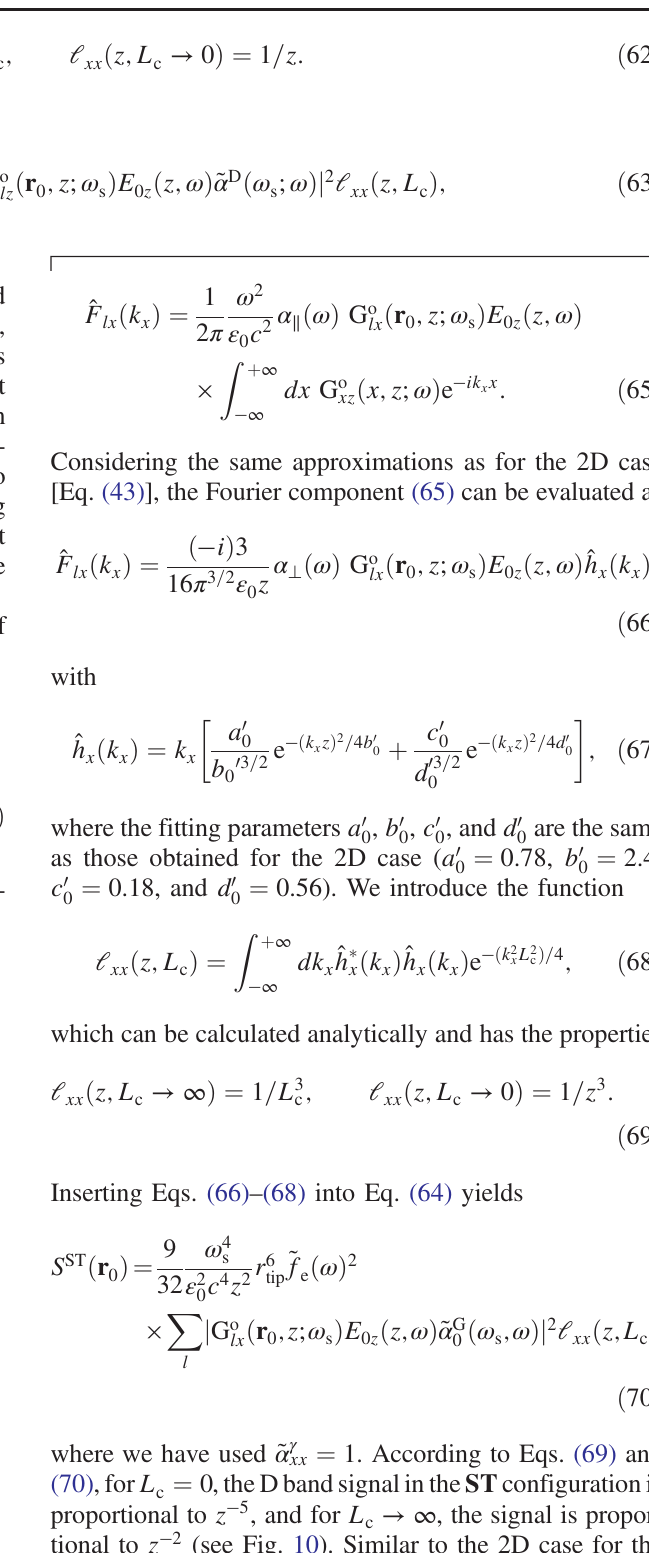
FIG. 9. Dependence of the TST of the D band on tip-sample separation z . Panels (a-d) account for different values of L 30, and 45 nm, respectively, as indicated in the graphics. In all ~ f 3 and r 15 nm. The signal S ð r cases, we used e ¼ tip ¼ 20 normalized to 1 at z min ¼